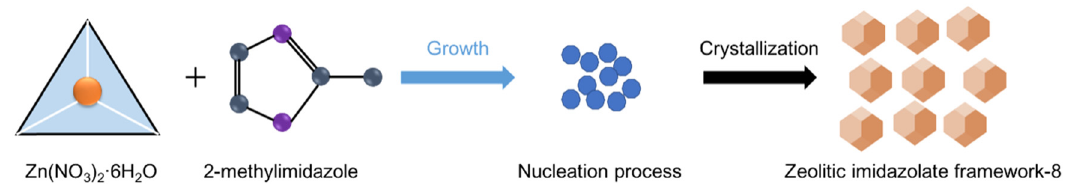
Figure 1: Scheme of the synthesis process of ZIF - 8